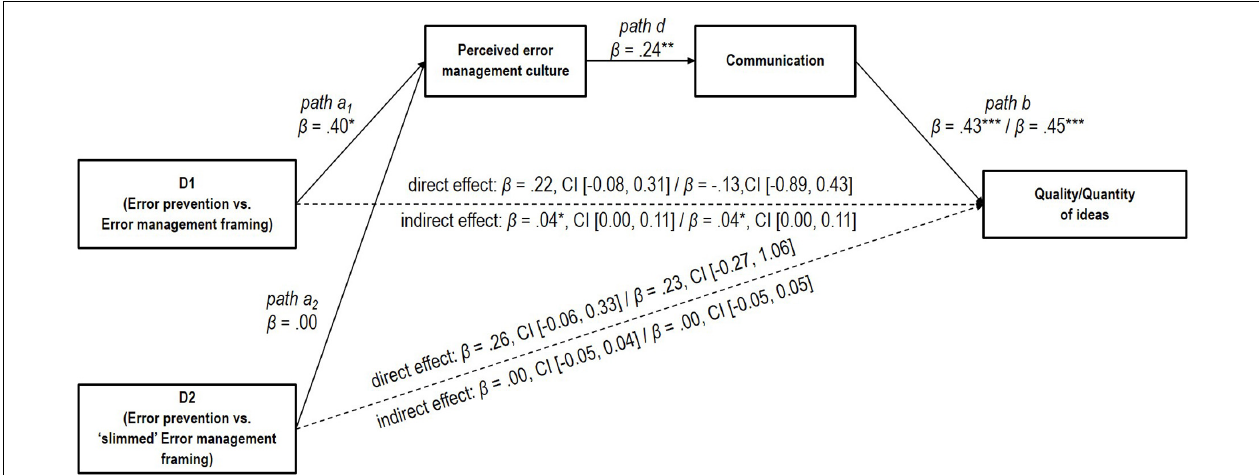
FIGURE 2 | Alternative mediation model in Study 2. The significant indirect effect of dummy variable D1 for our manipulation [i.e., error prevention (coded 0) vs. error management framing (coded 1)] and the non-significant indirect effect of dummy variable D2 for our manipulation [i.e., error prevention (coded 0) vs. “slimmed” error management framing (coded 1)] on performance (quality or quantity of ideas) through perceived error management culture and communication in Study 2. The dashed arrows indicate the direct paths between the dummy variables for our manipulation (D1 and D2) and performance. Standardized and partially values and confidence intervals (CI). N = 128 teams, * p < 0.05, ** p < 0.01, *** p <